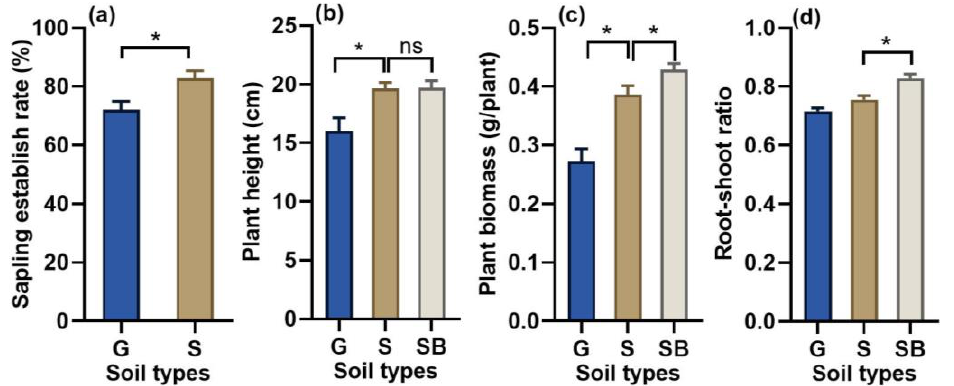
Figure 2. Effect of soil types on sapling establish rate ( a ), plant height ( b ), plant biomass ( c ) and root -shoot ratio ( d ) of Caragana stenophylla (mean ± SE). G, grassland soil; S, sandy land soil; SB, sandy land + sand burial. * indicate significant differences between G and S, and between S and SB, p < 0.05, ns indicates not significant difference, p > 0.05, t -test.